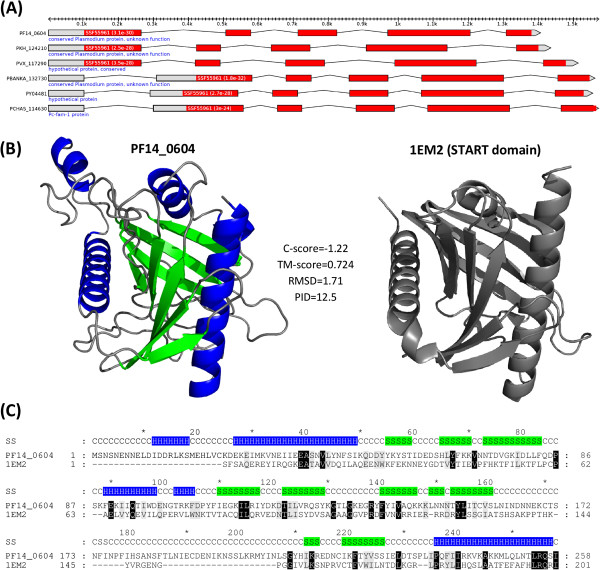
PYST-A proteins predicted to be involved in lipid binding and transfer. (A) Predicted Bet v1-like superfamily domain (SSF55961, in red) in selected pyst-a gene family members from six Plasmodium species. Hmmer3 E-values shown in parentheses. (B) I-TASSER predicted homology model (C-score = −1.22) of the single P. falciparum pyst-a gene family member PF14_0604 (left) next to crystal structure of steroidogenic acute regulatory-related lipid transfer (START) domain-containing human protein MLN64 (PDB entry 1EM2; right). Predicted alpha helices and beta strands of PF14_0604 highlighted in blue and green, respectively. Note the overall high similarity between the two structures (TM-score = 0.724; RMSD = 1.71) (C) Protein sequence alignment obtained by threading PF14_0604 onto 1EM2 using MUSTER. Percent sequence identity (PID) of structurally aligned residues is 12.5% over 78% of PF14_0604 sequence length. Secondary structure (SS) elements colored according to structural model in B. Identical and similar amino acids colored in black and gray, respectively. Sequence and structural similarity suggest a potential role of the pyst-a gene family in lipid binding and transfer.